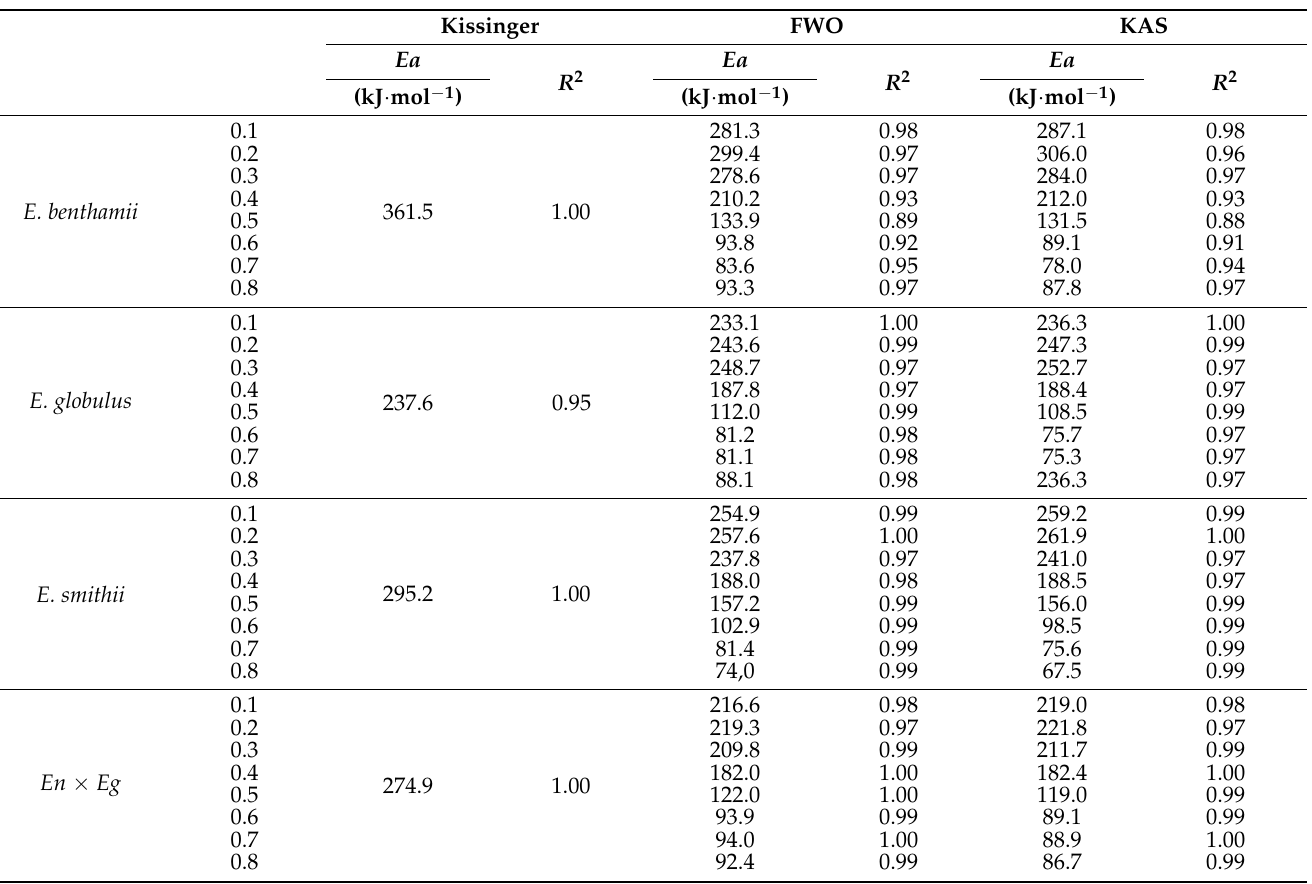
Figure 7. Application of the Kissinger method for the thermal decomposition of CNCs obtained from the different eucalyptus species. Table 7. Apparent activation energy ( Ea ) for the thermal decomposition of CNCs obtained from the different eucalyptus